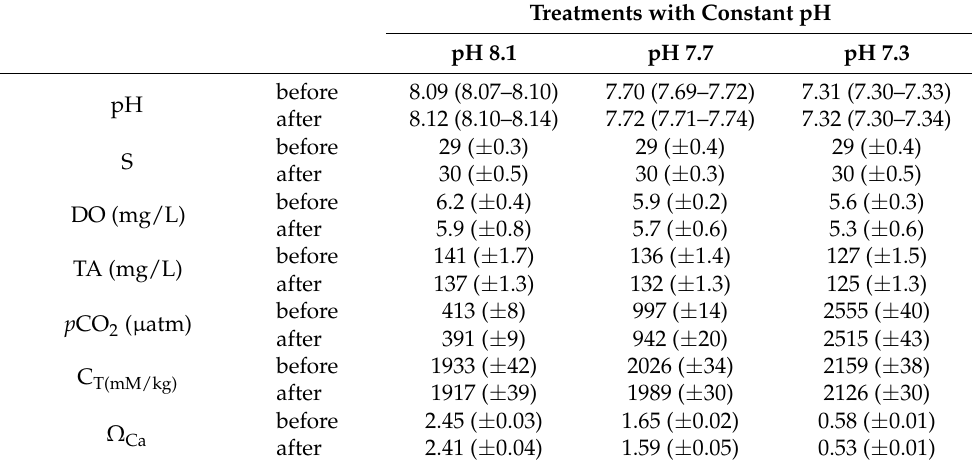
Table 1. Environmental parameters of the control group before and after water renewal during the experiment. The pH (NBS scale), temperature (T), salinity (S), dissolved oxygen (DO), and total alka- linity (AT) were measured. All other values (partial pressure of carbon dioxide: p CO 2 ; total dissolved inorganic carbon: C T ; and calcium carbonate saturation state for calcite: Ω Ca were calculated using CO2Sys from pH and total alkalinity. The pH values represent means [n = 30 for the treatments with constant pH] (maximum value − minimum value). The values of salinity, dissolved oxygen, total alkalinity, and other calculated factors represent means [ ± standard deviation (SD); n = 30] for the first three treatments with constant pH levels.